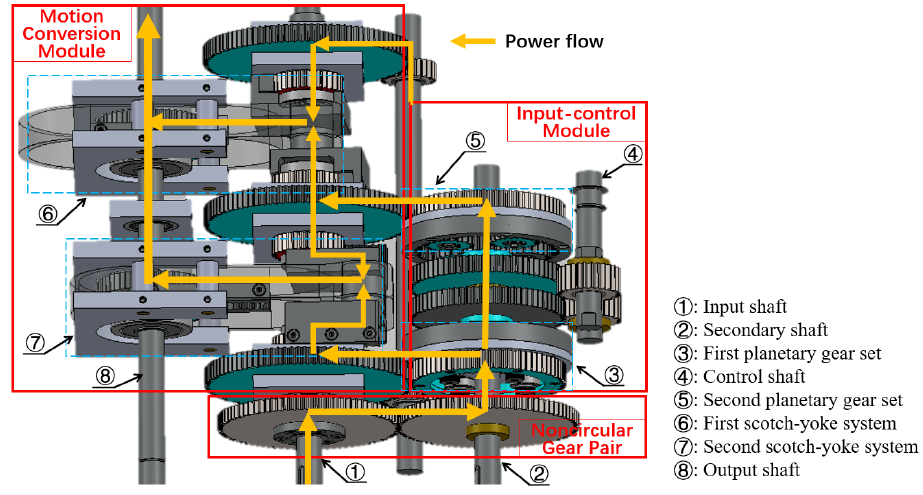
Figure 7. Schematic of the IVT